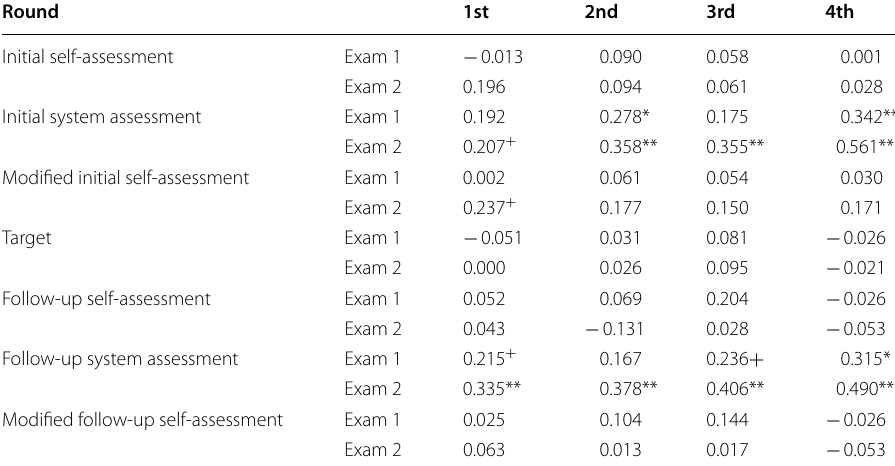
Table 4 Correlation of student self-assessment, system assessment, target goals, and performance